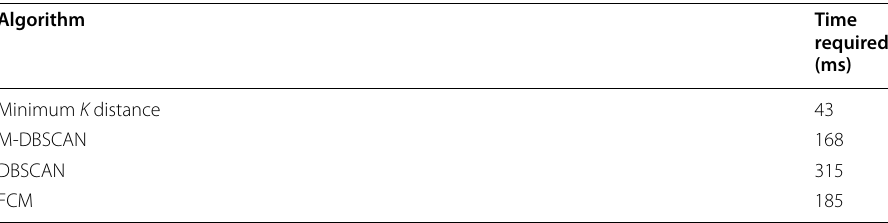
Table 4 Average time required for each position estimation